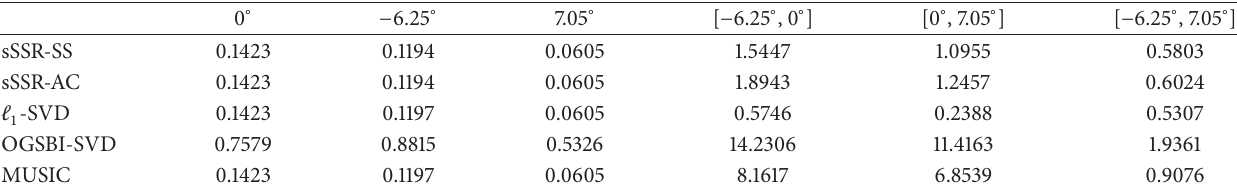
Table 1: The RMSE of DOA estimation in real data